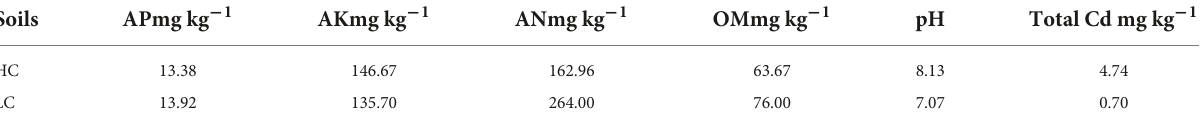
TABLE 1 Basic physical and chemical properties of